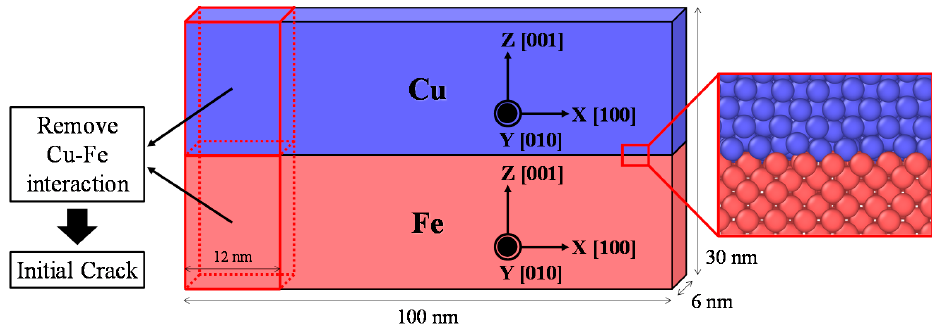
Figure 8. Cu/Fe interface model used in delamination growth simulation (Model 1).